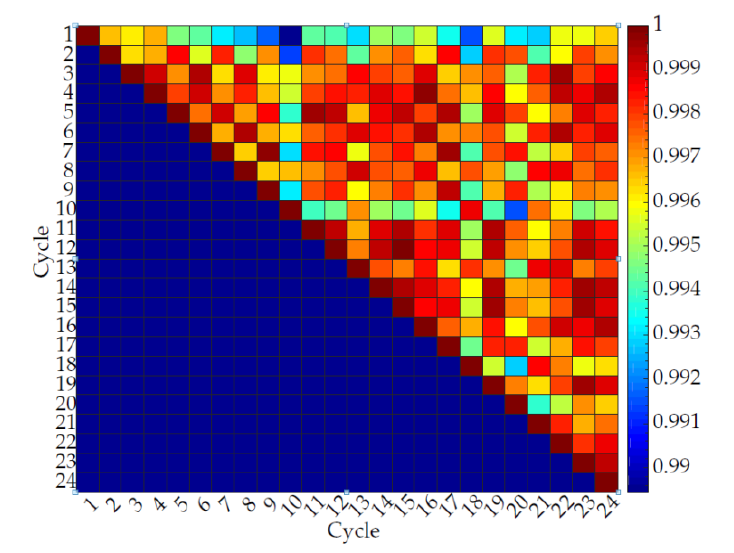
Figure 24. Normalized cross-correlation between sinusoidal motions for a band with a low iteration frequency (5 cycles/min) and low stretch length (0.5 mm).